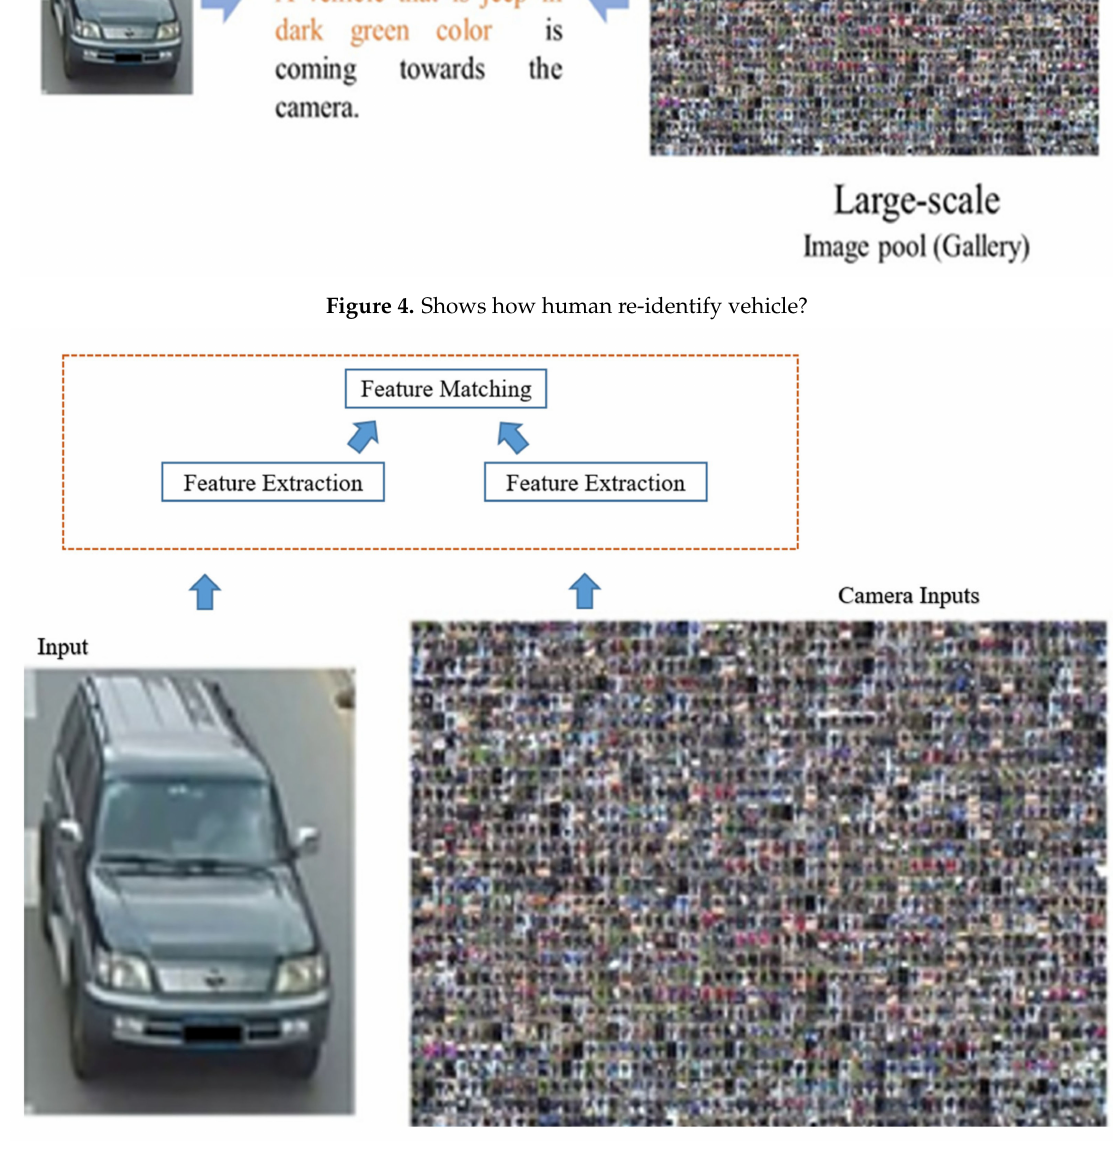
Figure 5. Illustrates how machine re-identify